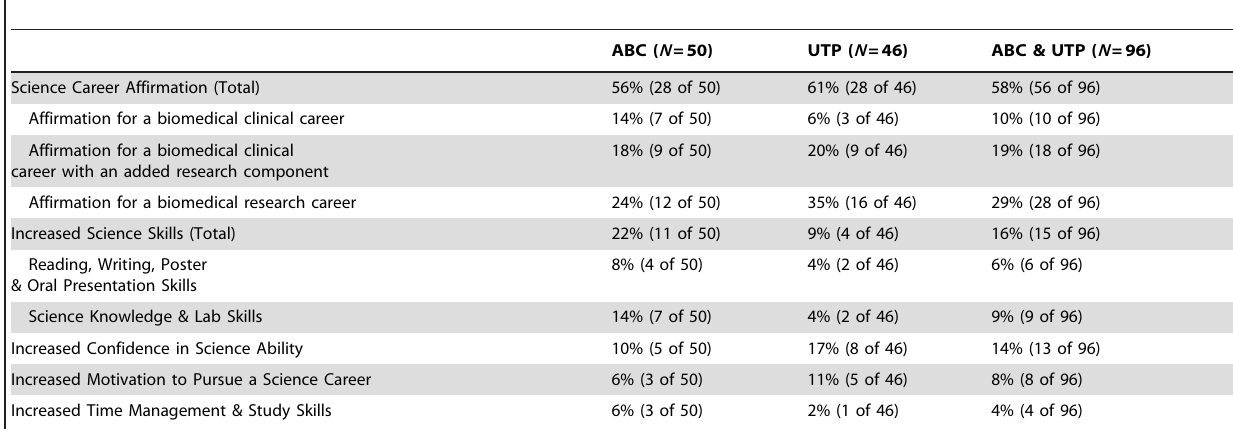
Table 5. Summary List of the Impact of the Summer Research Experience on Future Goals as Reported by the ABC & UTP Participants a (2008,